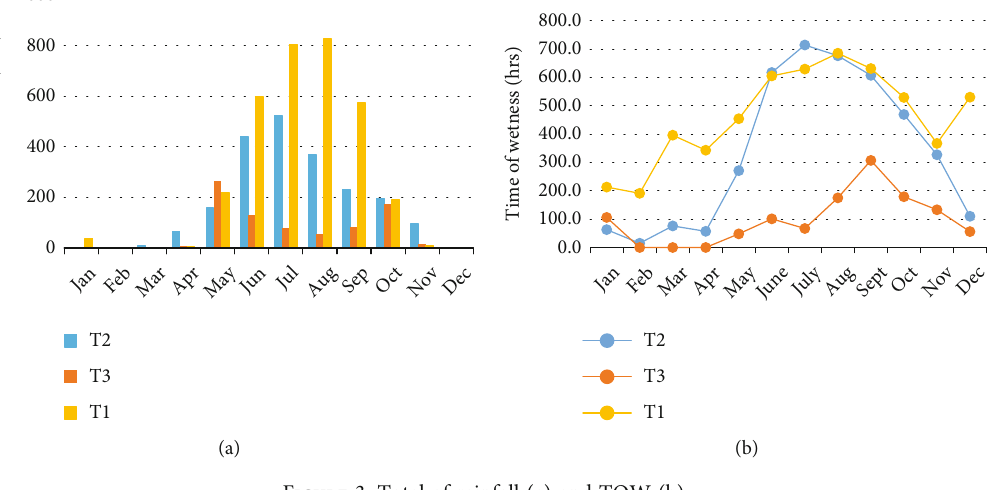
Figure 3: Total of rainfall (a) and TOW (b).